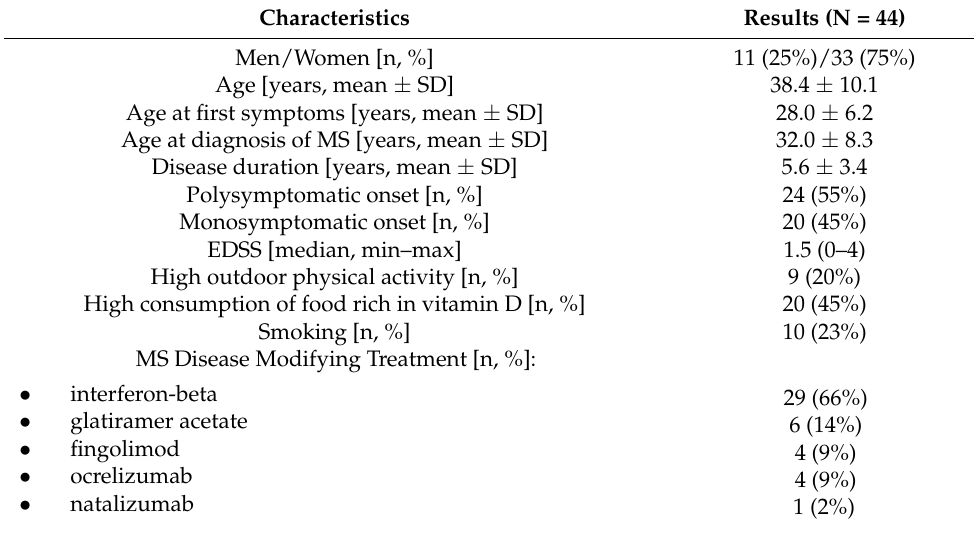
Table 2. Baseline demographic and clinical characteristics of studied group.